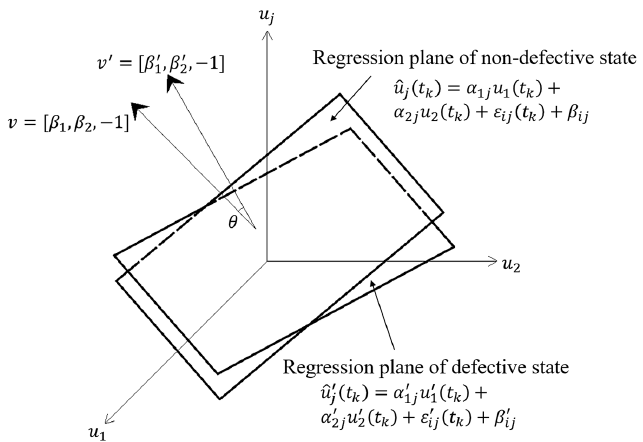
Figure 2. Geometric significance of the damage indicator θ in a two-variable spatial regression (TVSR) model.